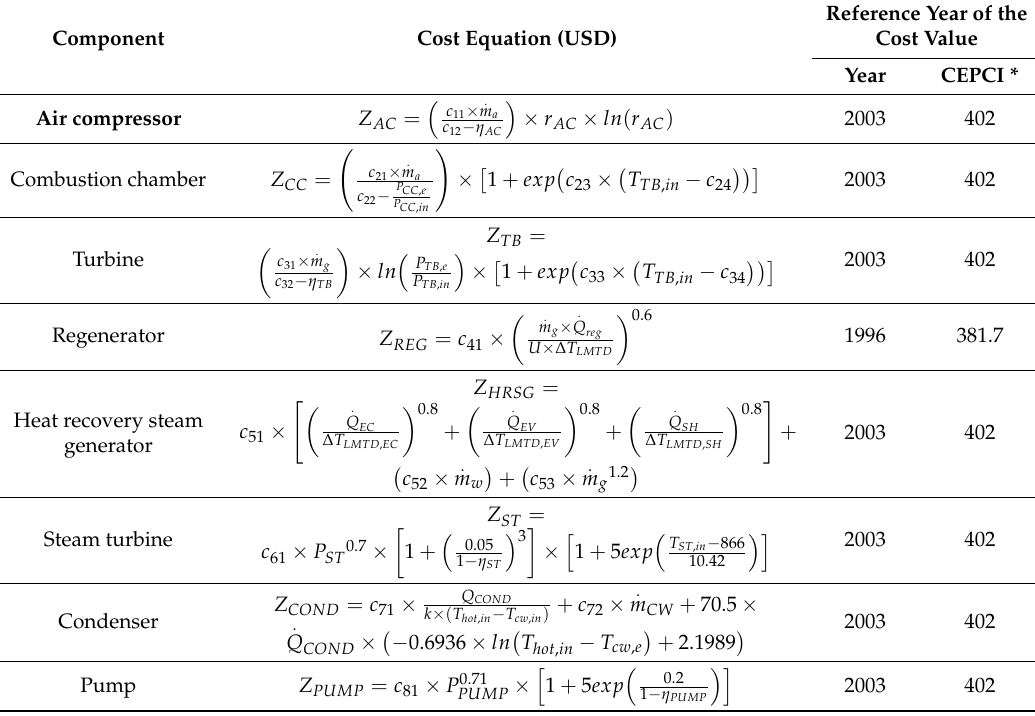
Table A1. Cost equations of each component in gas turbine power cycles.